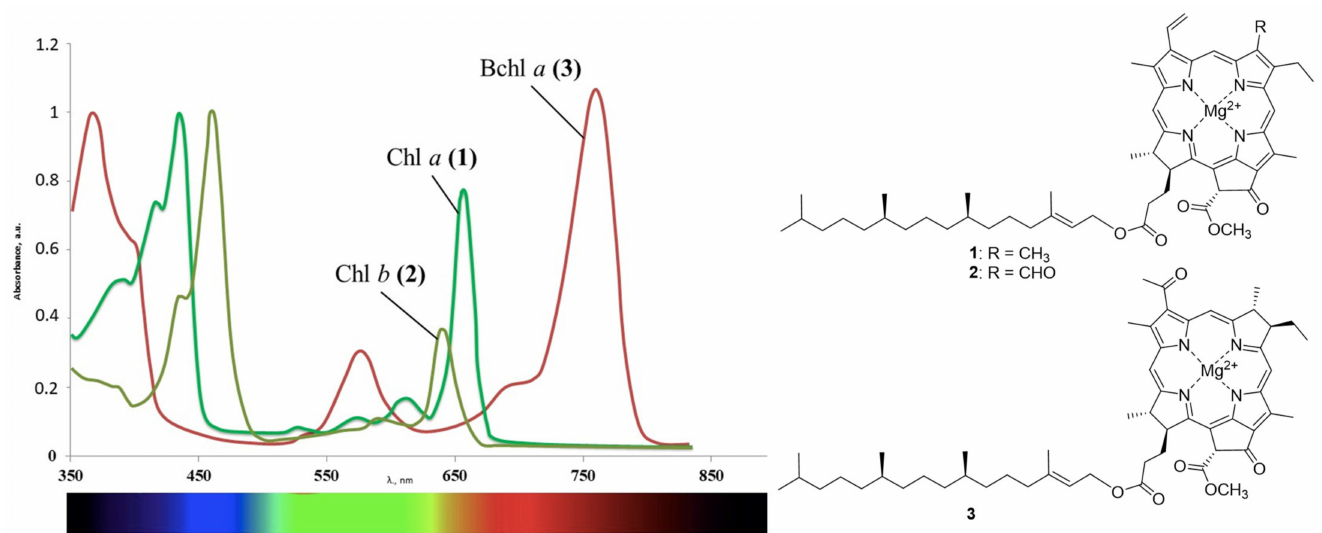
Figure 1. Chlorophyll a (1) , chlorophyll b (2) , bacteriochlorophyll a (3) , and their absorption